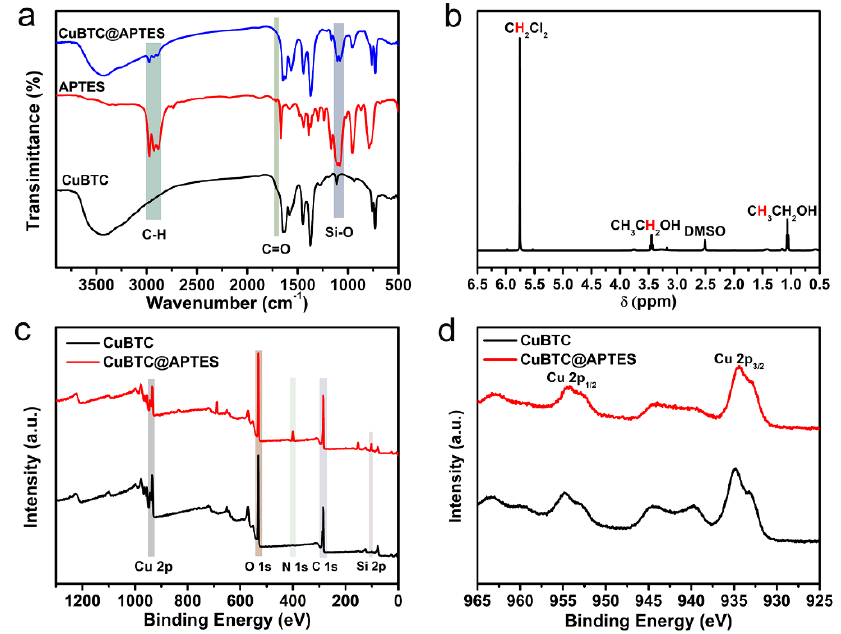
Figure 2. ( a ) FT-IR spectra of CuBTC, APTES and CuBTC@APTES; ( b ) 1 H NMR spectra of the reaction solution of CuBTC@APTES; ( c ) XPS spectra of CuBTC and CuBTC@APTES; ( d ) high-resolution XPS spectra for Cu2p in CuBTC and CuBTC@APTES.